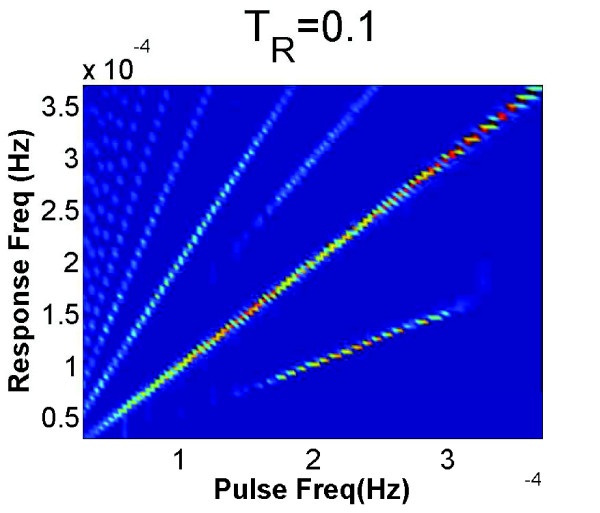
Response to periodic trains of weak pulses. A heat map summarising the power spectral density of NF-κB localisation when the model is subjected to pulsed forcing with TR = 0.1. For forcing frequencies in the range 1.5-3.0 × 10-4. Hz. the lowest-lying line segment, which has slope ≈ 1/2, provides evidence of subharmonic resonance.